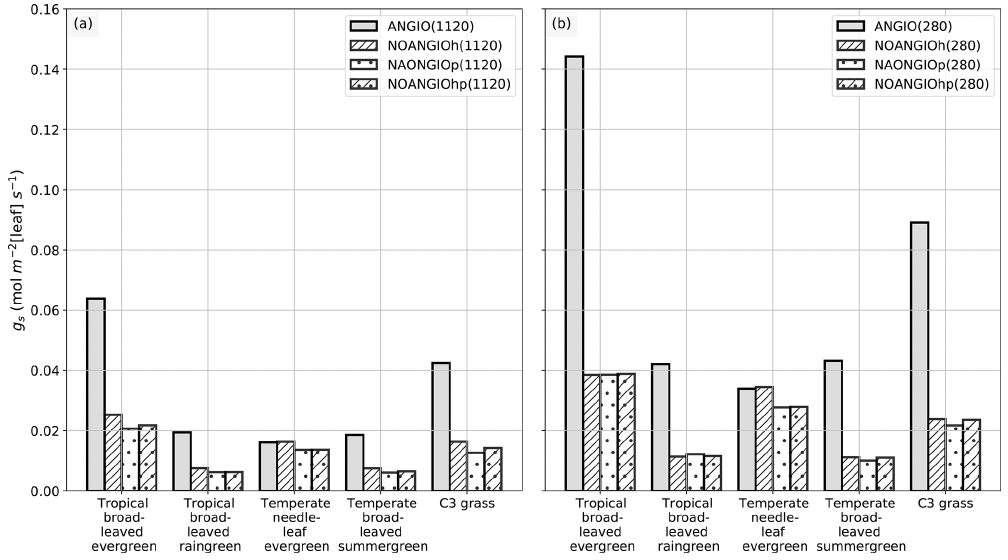
Figure 4. Global-scale leaf operating stomatal conductance to H 2 O g s (mol m − 2 [leaf] s − 1 ) per PFT: (a) ANGIO(1120) (gray bar), NOAN- GIOh(1120) (diagonal hatched bar), NOANGIOp(1120) (dotted bar) and NOANGIOhp(1120) (diagonal hatched and dotted bar); (b) AN- GIO(280) (gray bar), NOANGIOh(280) (diagonal hatched bar), NOANGIOp(280) (dotted bar) and NOANGIOhp(280) (diagonal hatched and dotted bar). The leaf stomatal conductance to H 2 O is the global mean of annual daylight leaf stomatal conductance of the top of canopy